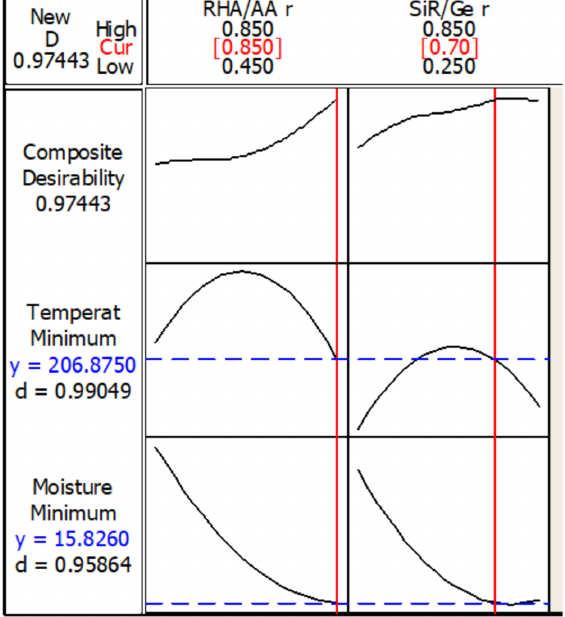
Figure 9. Optimization plot in the temperature at equilibrium and moisture